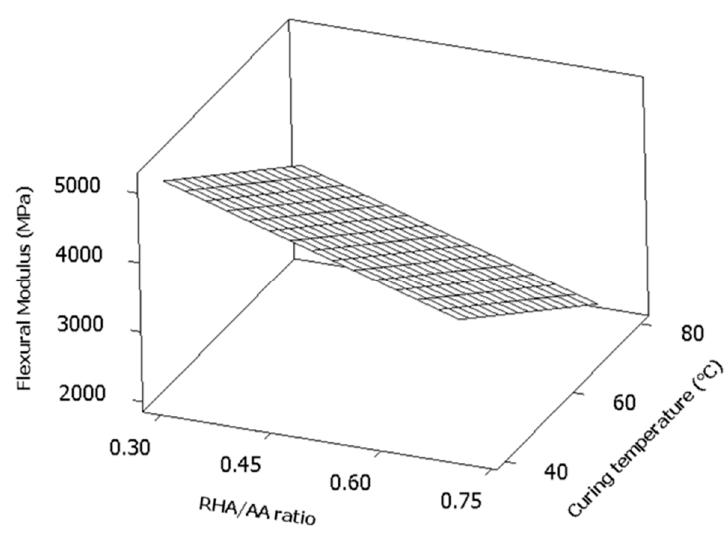
Figure 7. Surface plot of flexural modulus vs. curing temperature and the RHA/AA ratio.